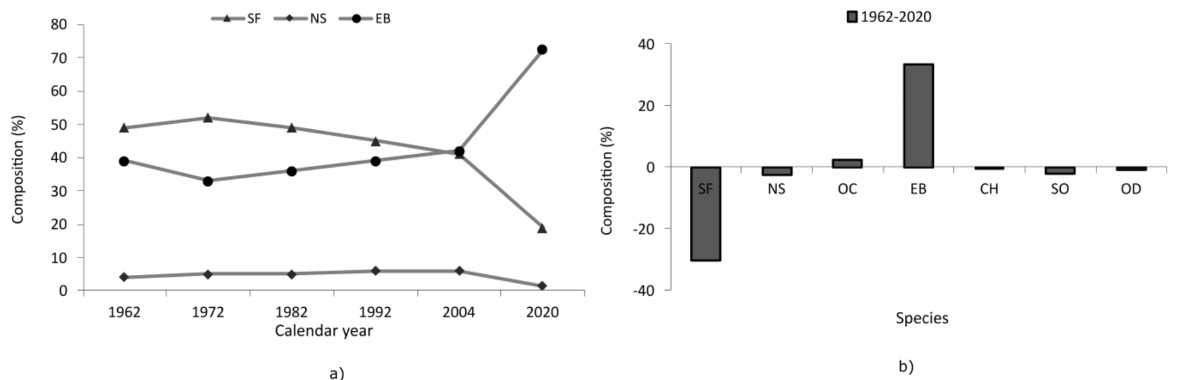
Figure 8. Dynamics of spruce, fir, and beech species in mixed beech–coniferous formations between 1962 and 2020 ( a ), and a comparison between the proportions of species in 2020 compared to 1962 ( b ). SF—silver fir, NS—Norway spruce, EB—European beech, OC—other conifers, CH—common hornbeam, SO—sessile oak, and OD—other